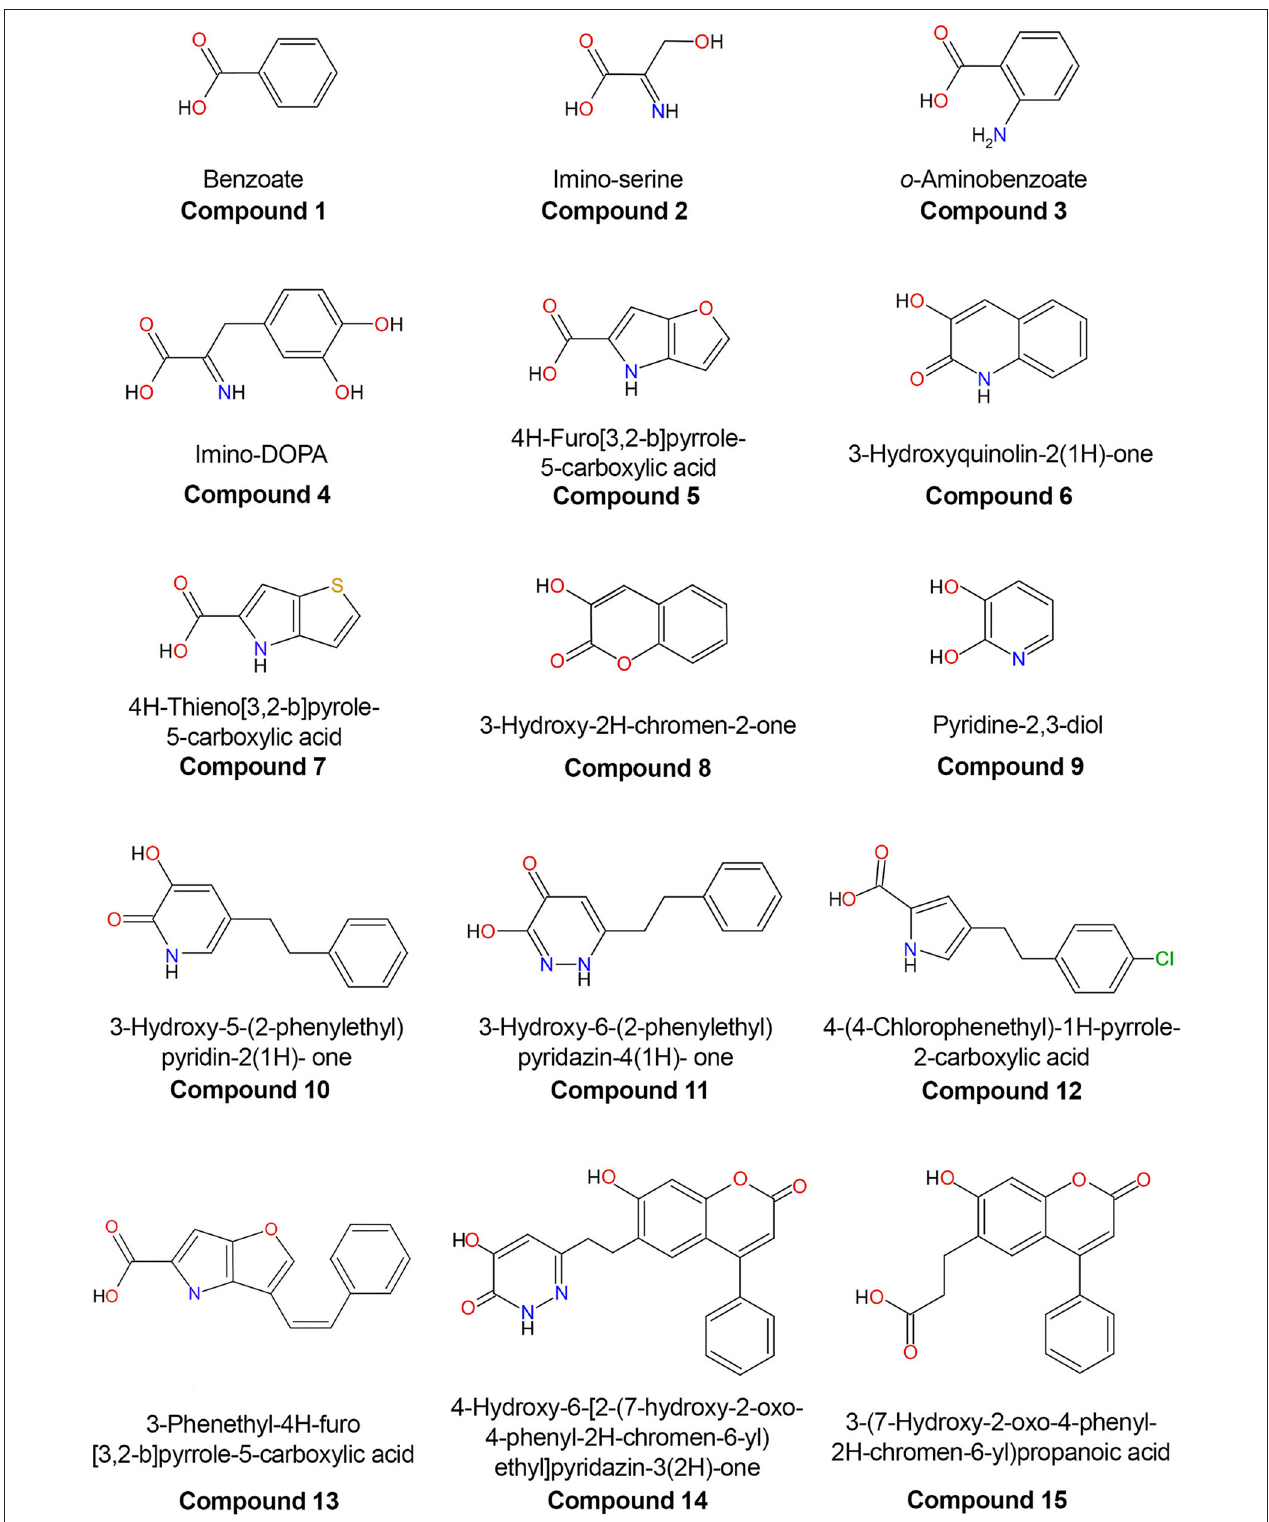
FIGURE 4 | Chemical structures of human D-amino acid oxidase ligands reported in Table 1.